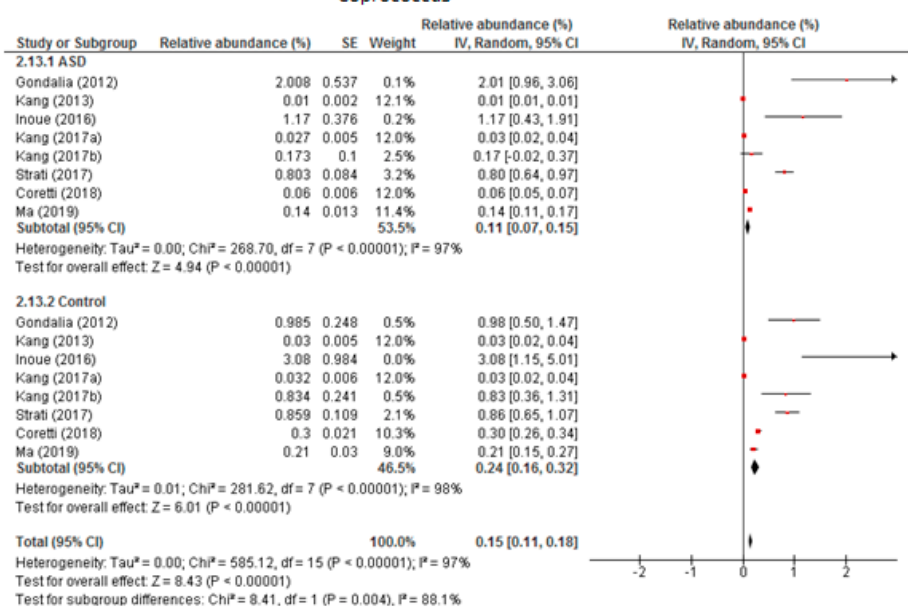
Figure 7. Forest plot of relative abundance of Coprococcus in children with ASD and controls.